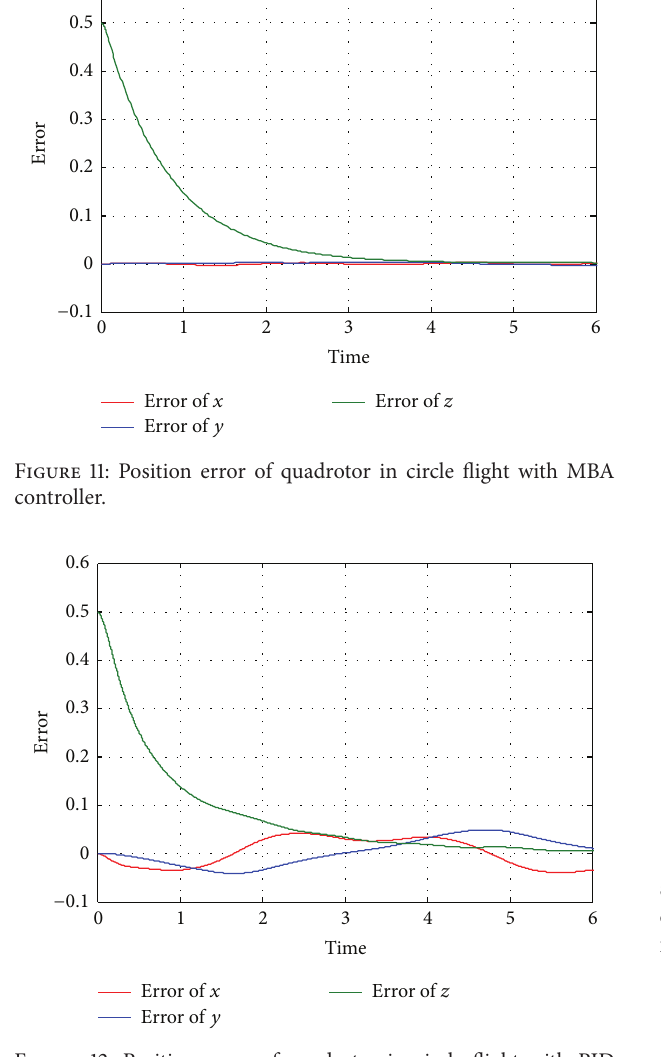
Figure 12: Position error of quadrotor in circle flight with PID controller.